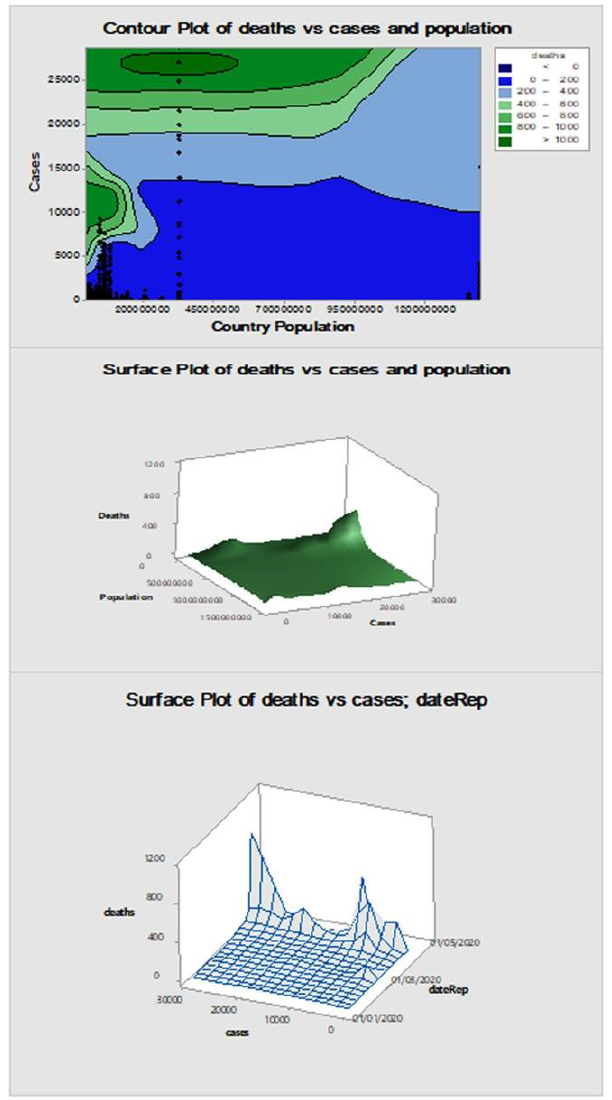
Figure 1: Contour, surface and wireframe plots of SARS- CoV-2 global pandemic morbidity/mortality plotted from time and countries population